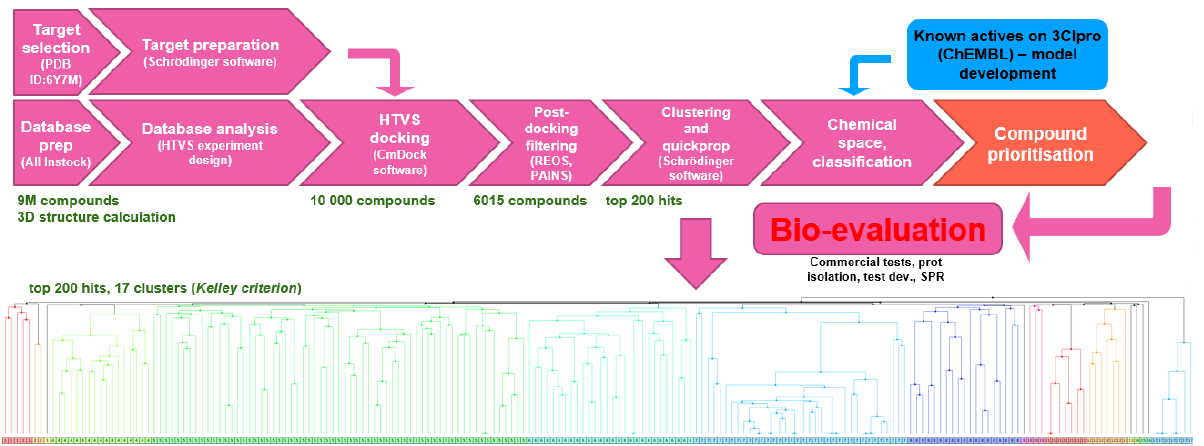
Figure 4. HTVS workflow with post-docking filtering, cluster analysis, and compound classification according to the chemical space of 3CL pro inhibitors collected in the ChEMBL database.